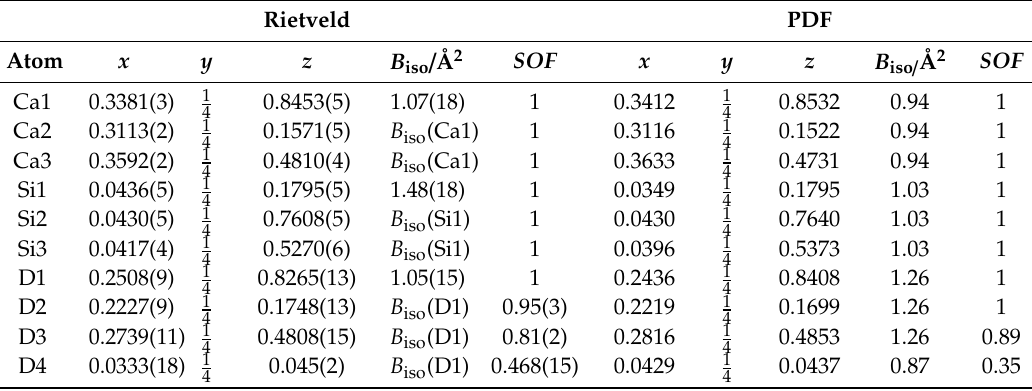
Table 1. Crystallographic data of CaSiD 1.1 , according to a Rietveld refinement with a bond length restraint ( a = 14.579(4) Å , b = 3.8119(4) Å , c = 11.209(2) Å ) and PDF small-box modelling ( a = 14.594 Å , b = 3.8200 Å , c = 11.230 Å ). Lattice parameters of the corresponding hydride CaSiH ≈1.1 are a = 14.6356(10) Å , b = 3.81207(15) Å , c = 11.2115(7) Å , based on laboratory X-ray diffraction.